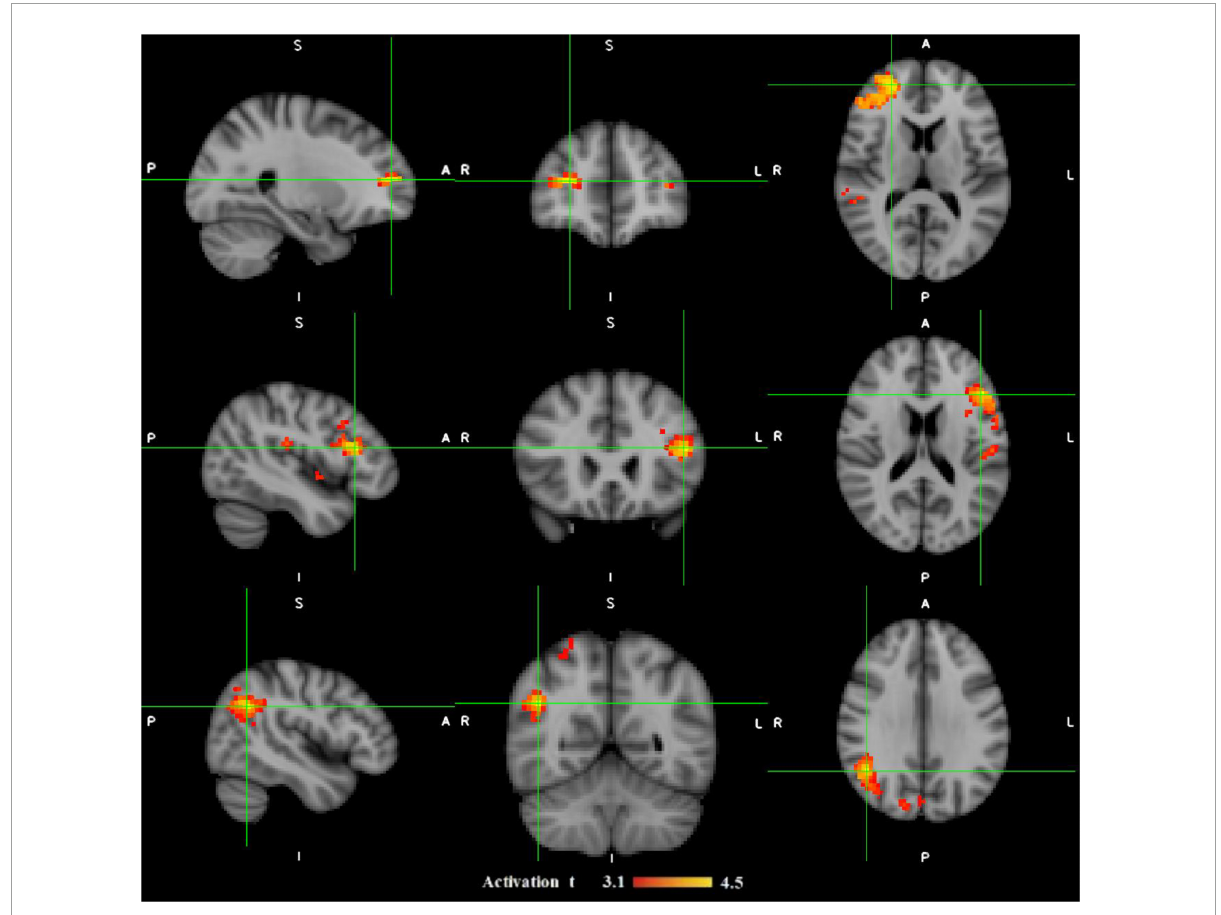
FIGURE3 The illustration of three epileptic foci (in each row) for three different patients with refractory focal epilepsy which are localized by functional connectivity analysis on fMRI data. The patient in the top had their seizure focus localized in frontal right; the one in the middle showed epileptic activation originated in fronto-temporal left; and the one in the bottom was predicted to have their epileptic focus in parietal right. The activation regions with t -values from 3.1 to 4.5 are shown in red-yellow color map. A, Anterior; I, inferior; L, Left; P, Posterior; R, Right; S, Superior (Sadjadi et al.,